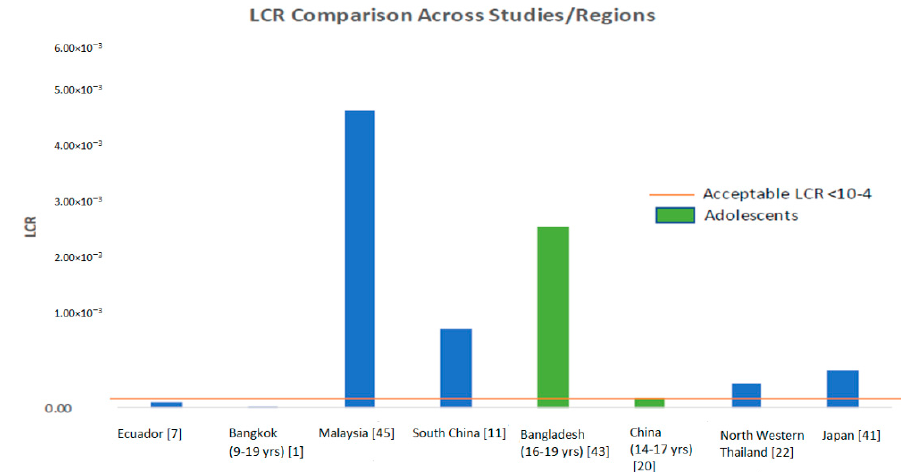
Figure 1. Comparison of LCR values from different studies and regions.